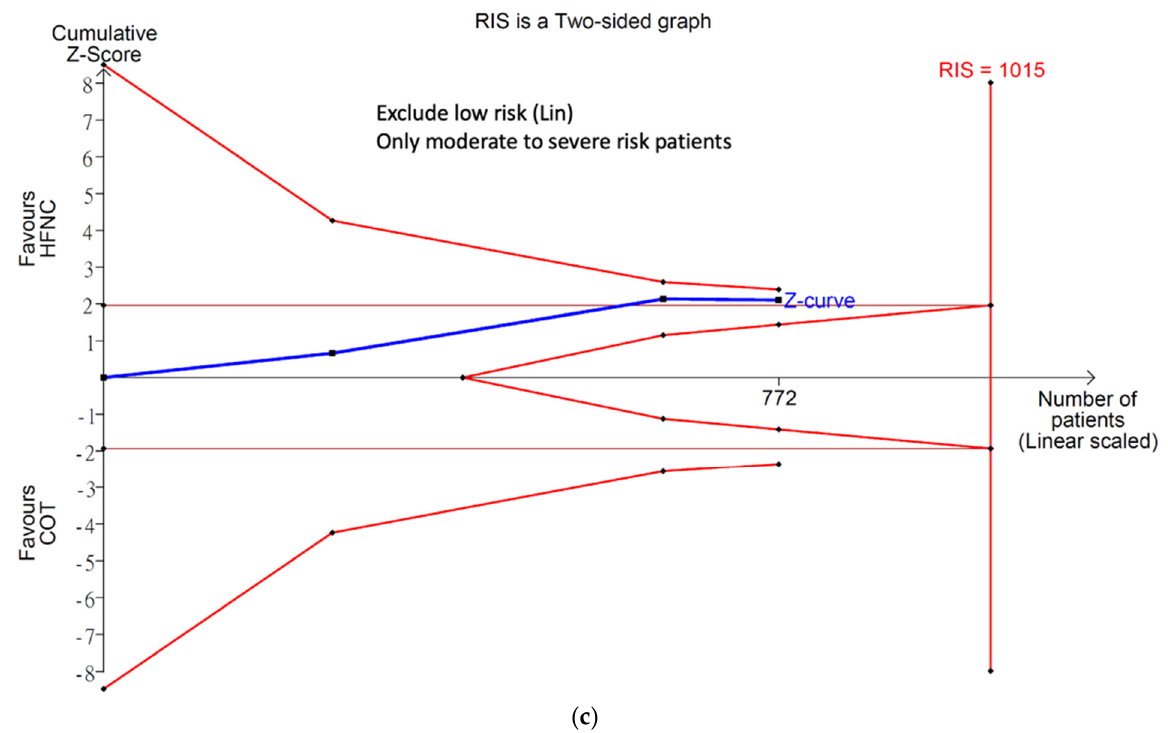
Figure 4. Incidence of severe hypoxemia. ( a ) Meta-analysis with IVhet model; ( b ) trial sequential analysis; and ( c ) trial sequential analysis: patients with moderate to high risk for hypoxemia. Studies in Figure 4a include: Mazzeffi et al [14], Nay et al [16], and Thiruvenkatarajan et al [15].